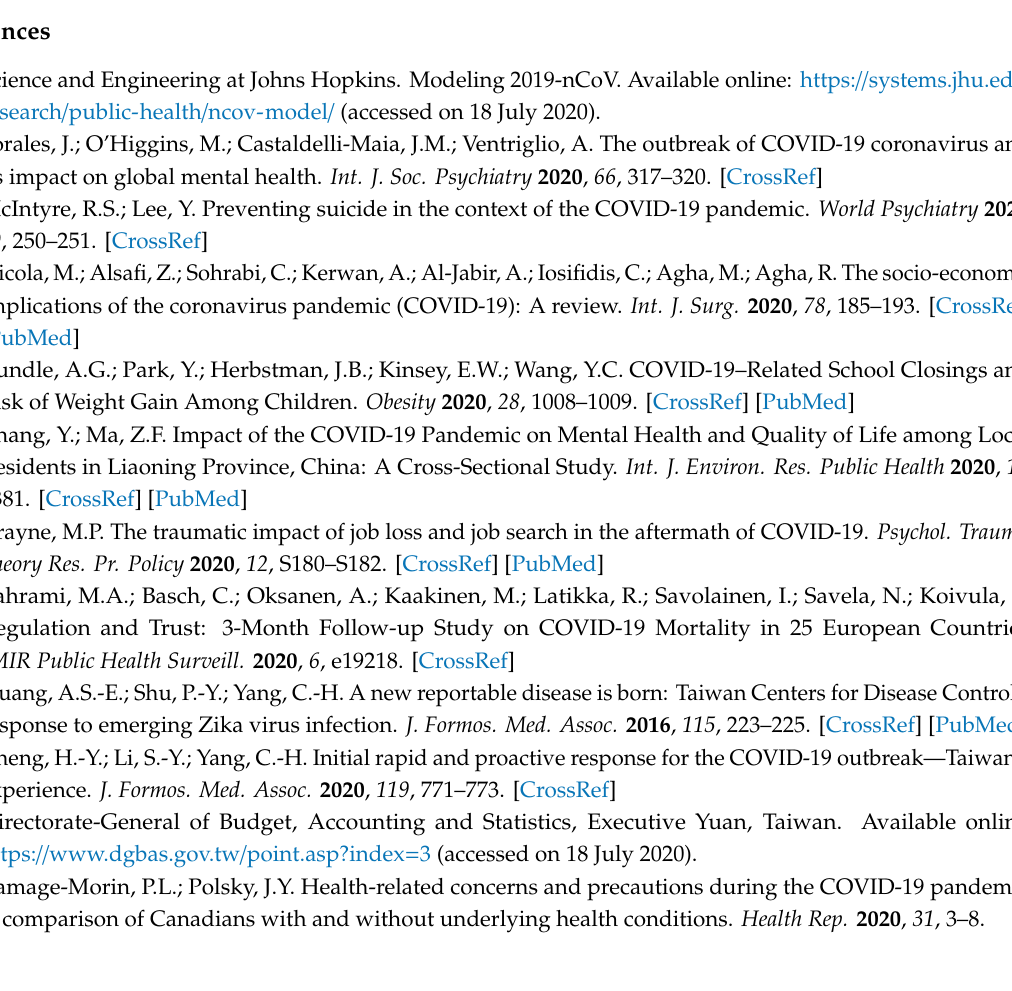
Table S1: Measures Used in This